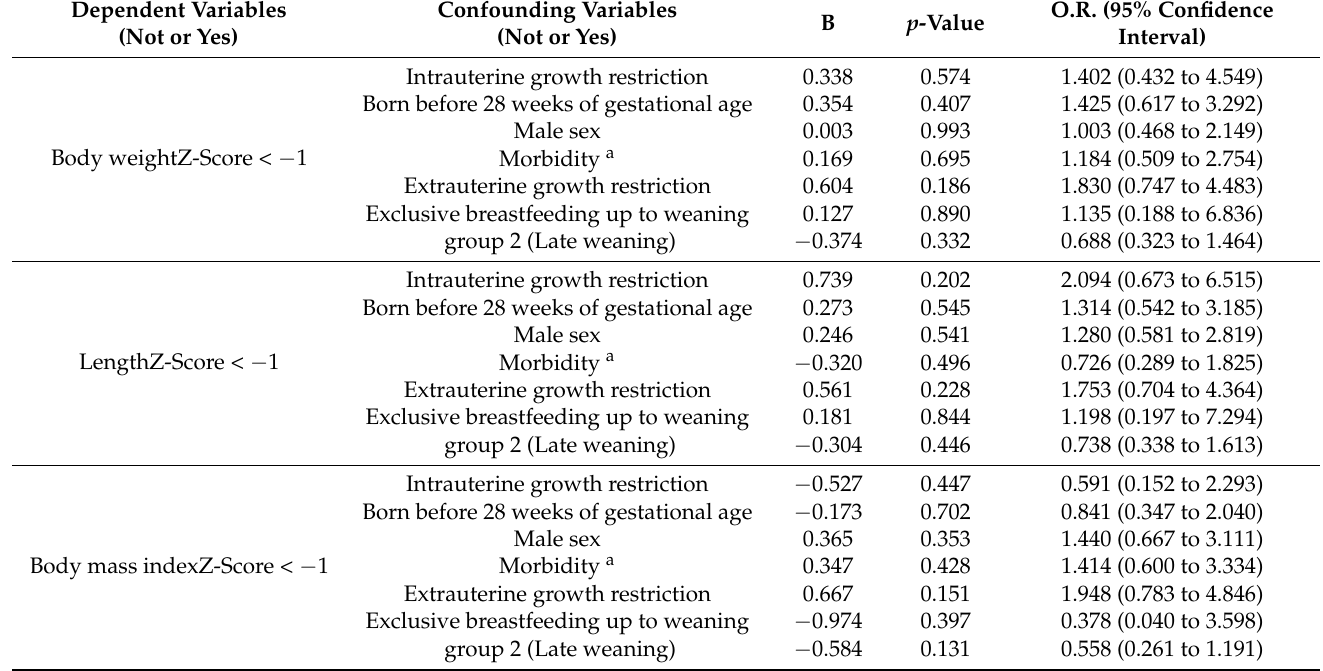
Table 6. Binary logistic regression analysis to evaluate the influence of confounding variables on primary outcome. Dependent